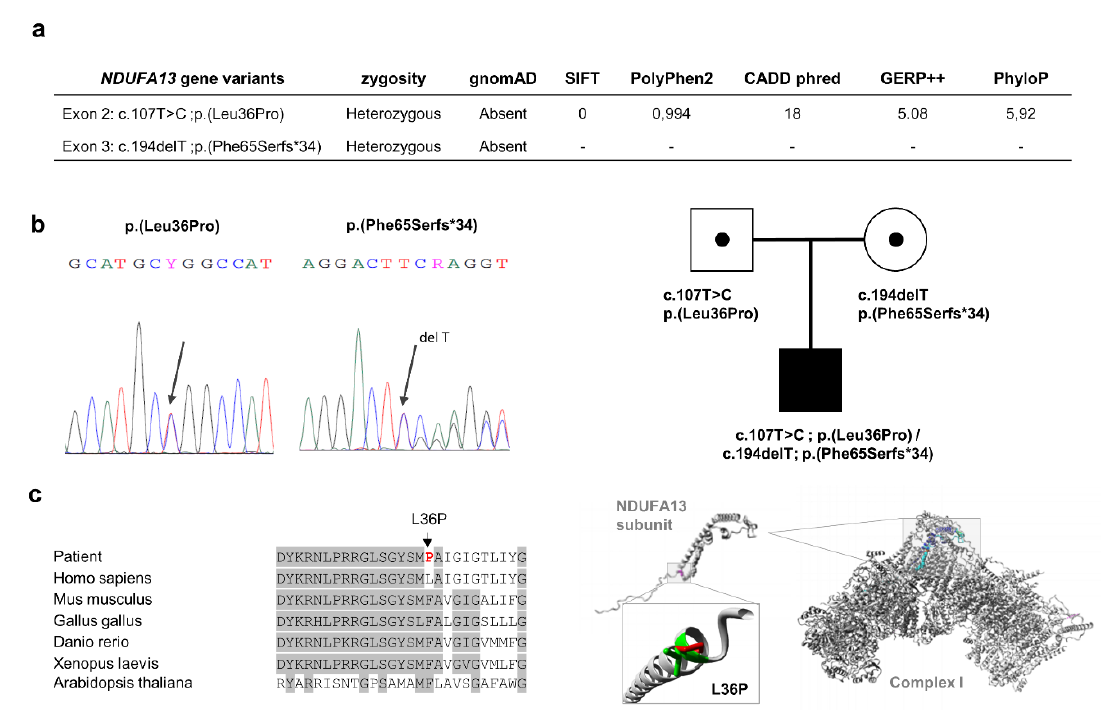
Figure 1. Variant analysis of the NDUFA13 gene . Panel ( a ) indicating the two prioritized variants in the NDUFA13 gene and some predictor scores, after the “OXPHOS panel” analysis. Panel ( b ) showing Sanger sequencing and family segregation of both variants. Panel ( c ) left side, denoting the evolutionary conservation region (gray color) where amino acid residue L36 is located in the NDUFA13 gene; red color, mutant proline residue; right side, structural analysis of p.(L36P) mutation using the HOPE program [25], representing the overlay of the wild-type and mutant (green and red, respectively) residues of the human NDUFA13 protein; the mutant residue (P) is smaller than the wild-type residue (L), while a destabilizing e ff ect of proline was described in the α helix structures [26], which might disrupt protein–protein interactions with other structural subunits to either assemble or stabilize complex I. OXPHOS: oxidative phosphorylation.